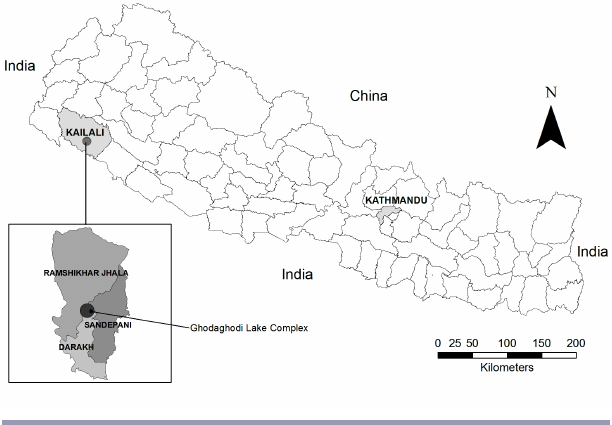
Fig. 1. Map of Nepal, indicating the location of the Ghodaghodi Lake complex study area